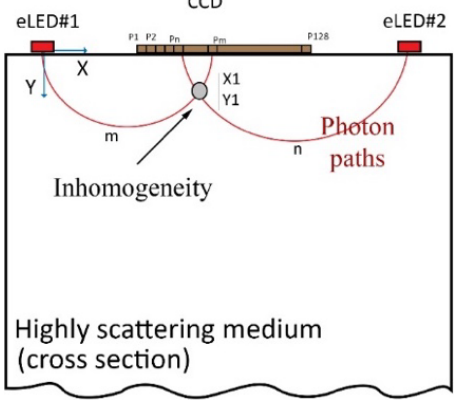
Fig. 3. Sketch of light propagation in highly scattering tissue.